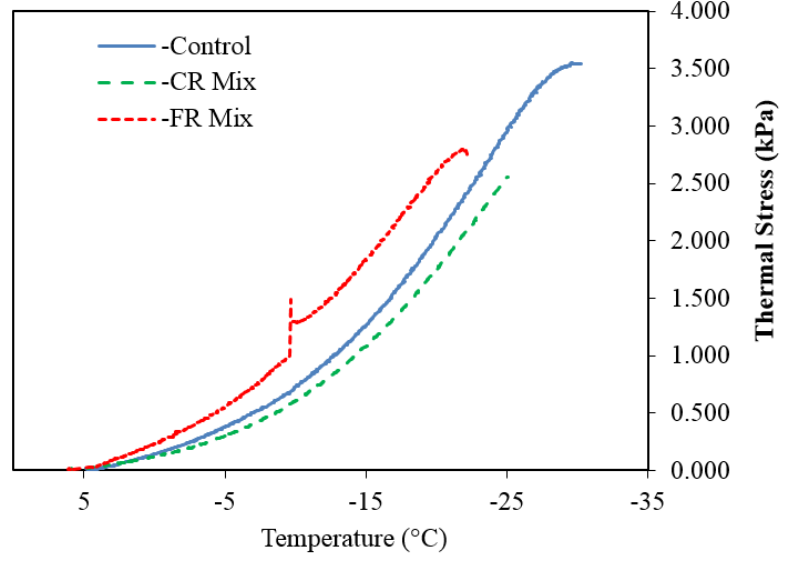
Figure 16. TRST results.